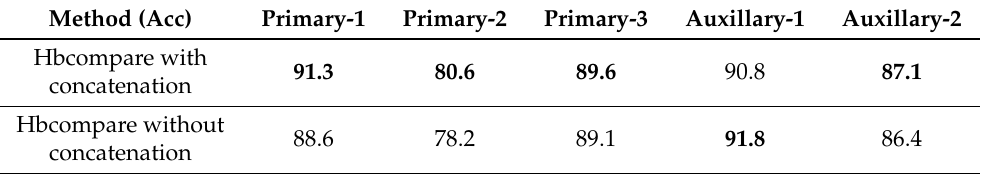
Table 5. Average classification accuracy of HBcompare model with and without concatenation strategy using only hydrogen bond topology across all folds. The more accurate method is